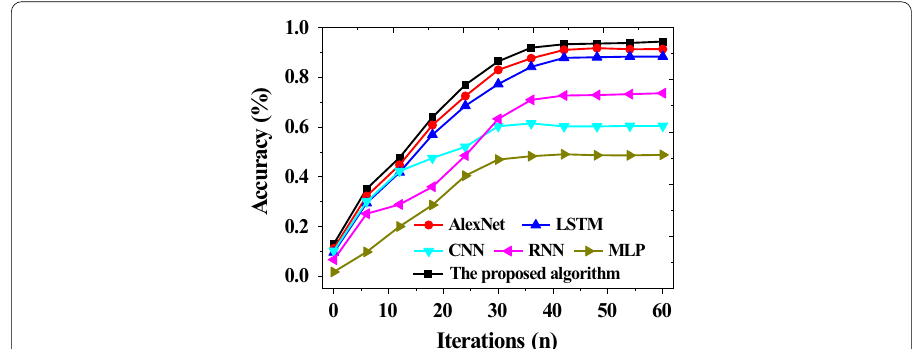
Fig. 5 Accuracy curves of different algorithms with the increase of iteration times